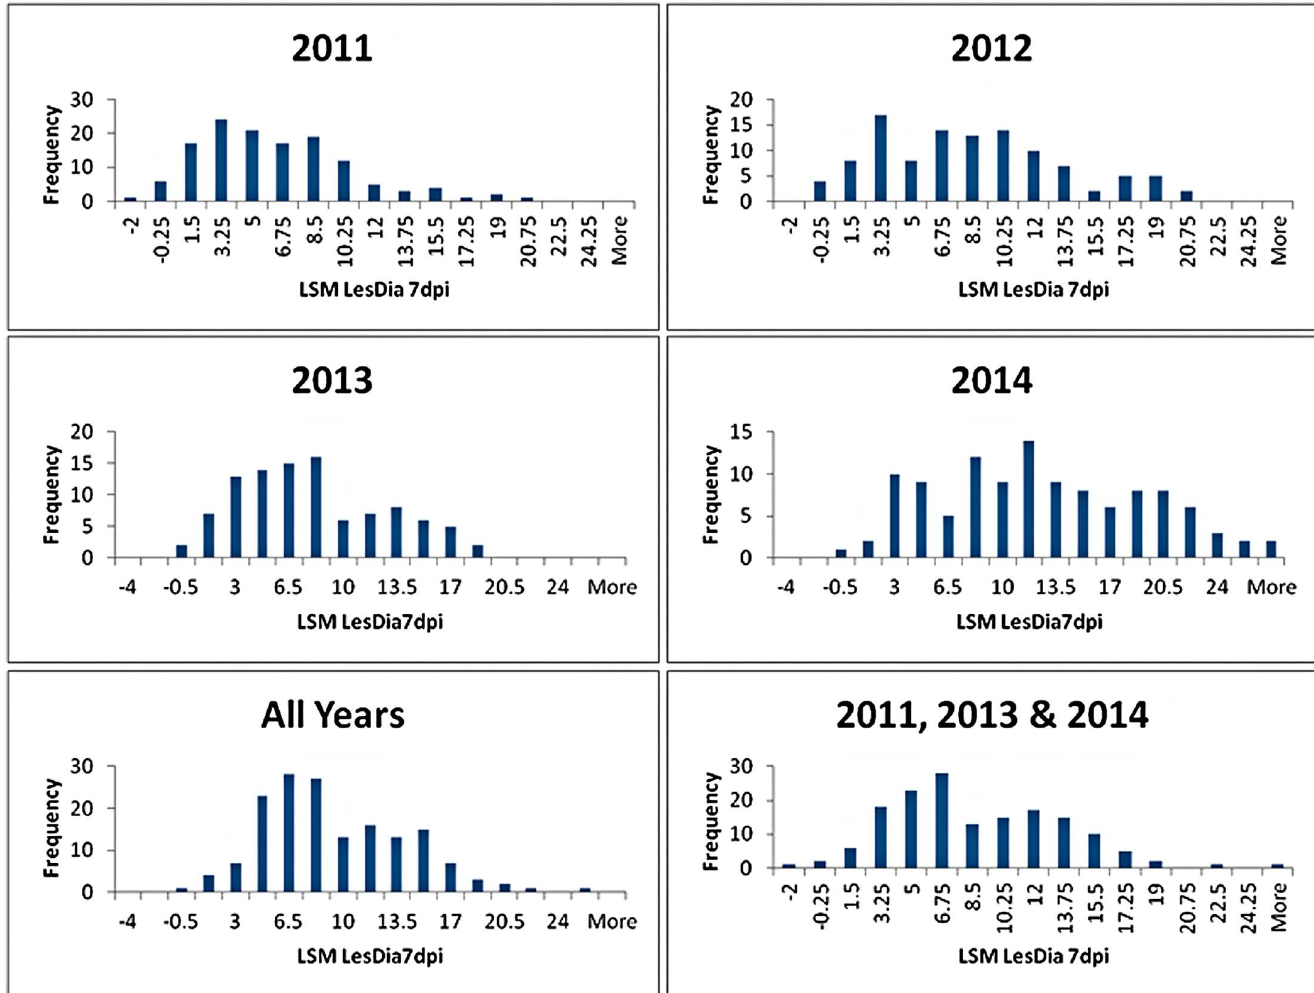
Fig 2. Histograms illustrating the frequency distribution of blue mold resistance within the GMAL4593 mapping population in multiple years. Resistance measurewas the least square (LS)mean of blue mold lesion diameter7 days post-inoculation (LSM LesDia7dpi in figure) of a uniform, fruit- surface woundwith P . expansum calculatedfrom a mixed linear model in which accession and fruit starch content were fixed-effects parameters, and fruit harvest date and specific blue mold evaluation test were random-effects parameters.